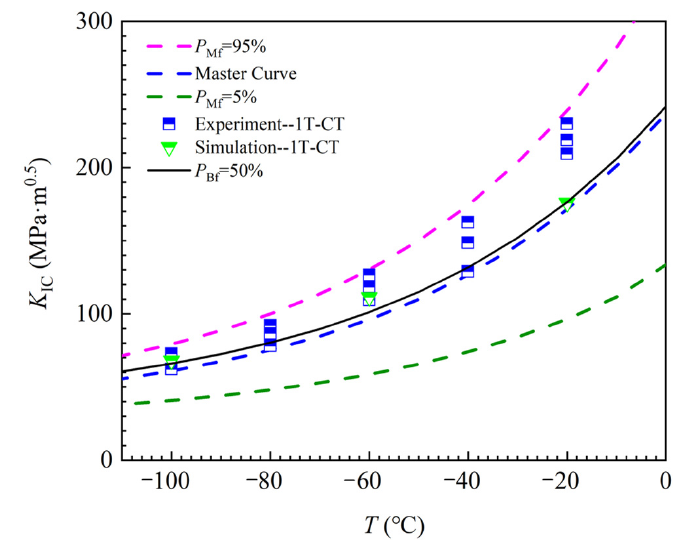
Figure 16. Cumulative failure probability distribution of fracture toughness of 0.5T-CT sample and 1T-CT sample.